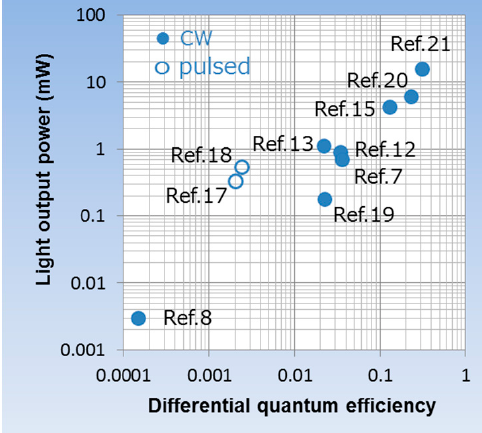
Figure 1. Light output power as a function of differential quantum efficiency for reported GaN-based VCSELs [7,8,12,13,15–21]. The open and closed circles indicate pulsed operation and CW operation, respectively.